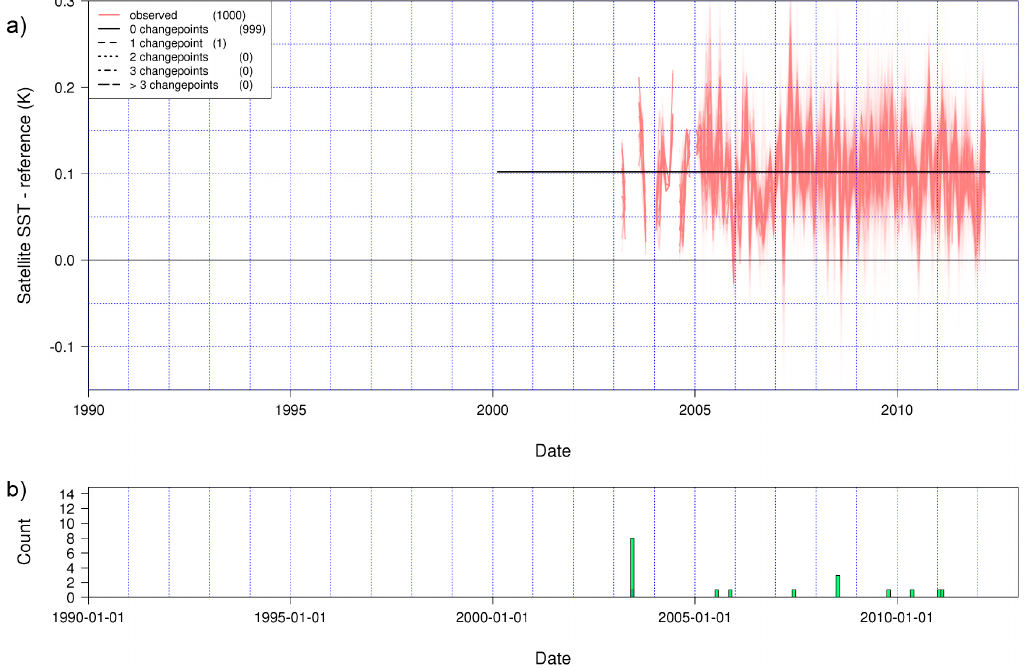
Figure 9. As for Figure 3 but for Argo observations. ( a ) The monthly mean differences (satellite in situ) for the individual ensemble members are shown in red. Also shown are the means of the model fitted by PMT grouped by number of change points detected. ( b ) Shows a histogram of the false